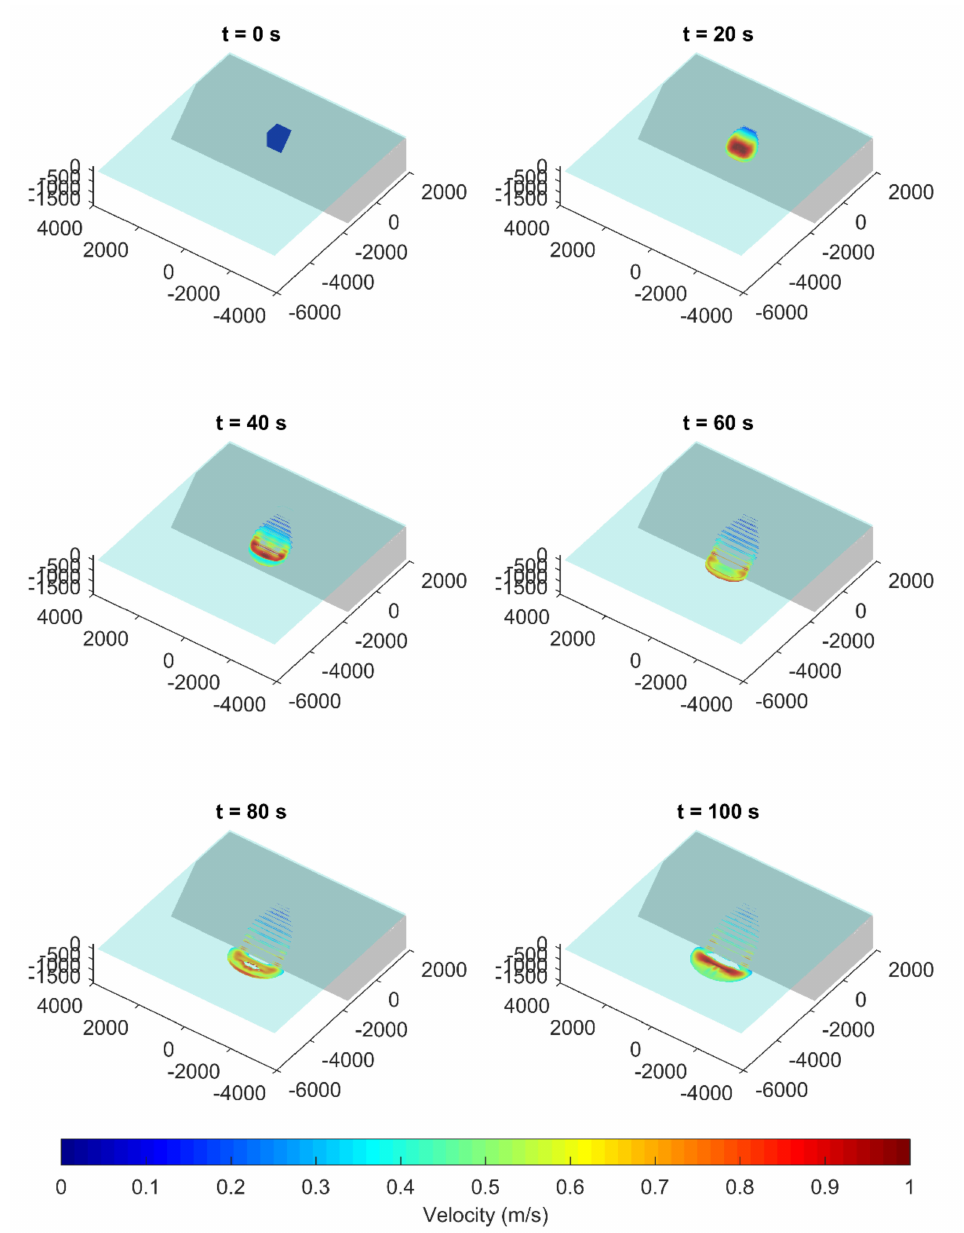
(cid:16) (cid:17) µ µ τ = y B , A ,